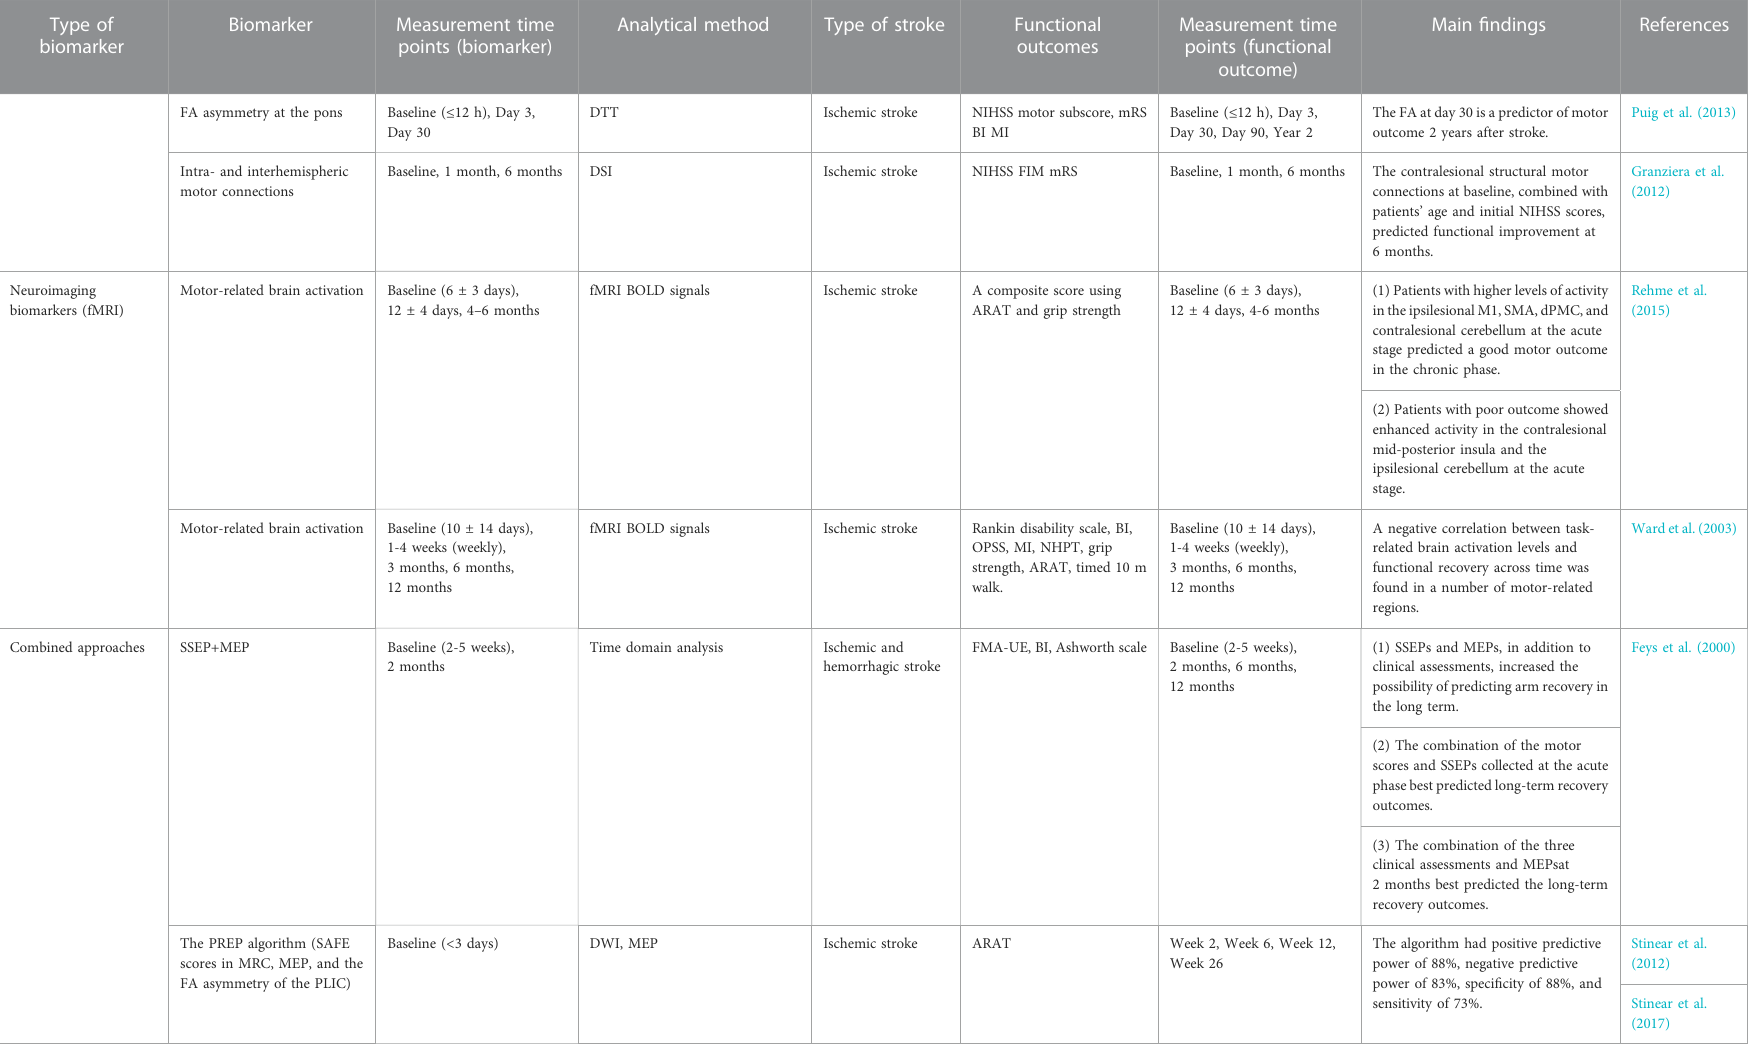
TABLE 1 ( Continued ) Neurophysiological and neuroimaging biomarkers for stroke prognosis.